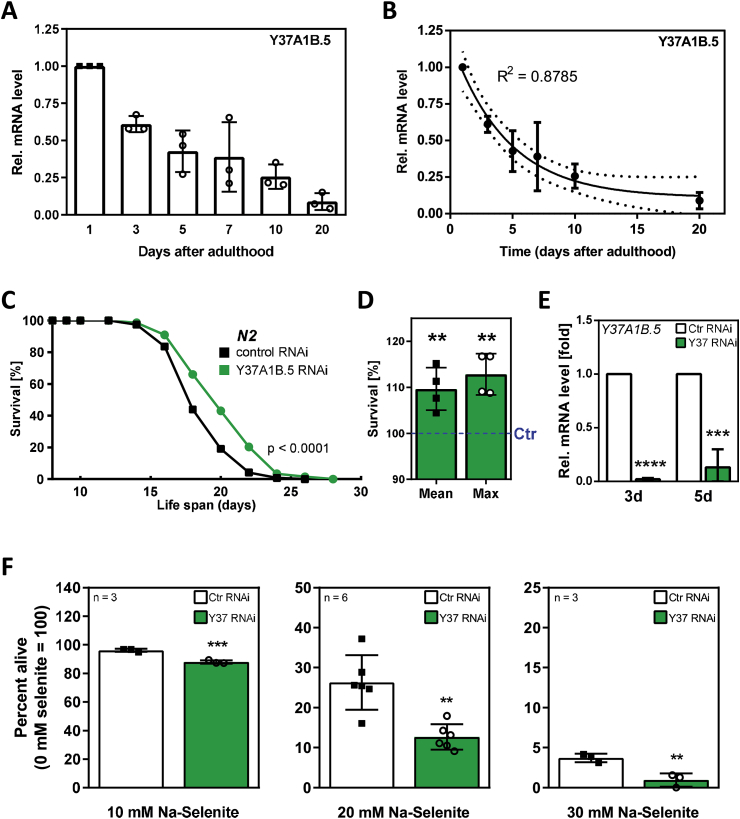
Y37A1B.5 mRNA levels decrease with age and its downregulation increases lifespan. (A) Relative Y37A1B.5 mRNA levels of N2 wild-type worms after 1, 3, 5, 7, 10 or 20 days, starting 64 h after synchronization, as determined in three independent experiments using qRT-PCR. Data were first normalized to mRNA levels of the housekeeping gene and then against the expression level of day 1. Data shown are relative means ± SD. (B) Exponential regression of data from graph (A). Data shown are means ± 95% confidence band. (C) Survival of nematodes depleted of Y37A1B.5 through RNAi (p<0.0001 vs. control, log-rank test). Age-synchronized young adult worms were subjected to Y37A1B.5-specific or control RNAi. Survival was monitored daily until the end of the reproduction period and every second day thereafter. The lifespan experiment was conducted in quintuplicates and was performed four independent times (for details, see Table 2). One representative experiment is shown. (D) Relative mean and maximum lifespan of four independent lifespan experiments with Y37A1B.5 RNAi or control. Data were normalized to mean or maximum lifespan of respective control experiment (**p<0.01 vs. control; unpaired t-test). (E) Relative Y37A1B.5 mRNA levels after three or five days of Y37A1B.5 RNAi or control, starting at the young adult stage, as determined in three independent experiments using qRT-PCR. Data shown are relative means +SD. (***p<0.001 vs. respective control; t-test) (F) Toxicity of different selenite concentrations to C. elegans following RNAi using control or Y37A1B.5-specific plasmids (***p<0.001, **p<0.01 vs. control; unpaired t-test).